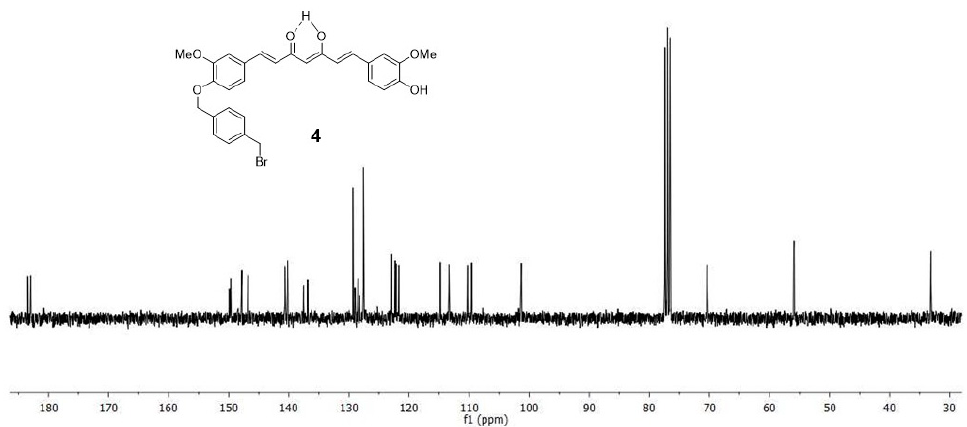
Figure 16. 1 H NMR spectrum of Compound 4 in CDCl 3 as solvent.